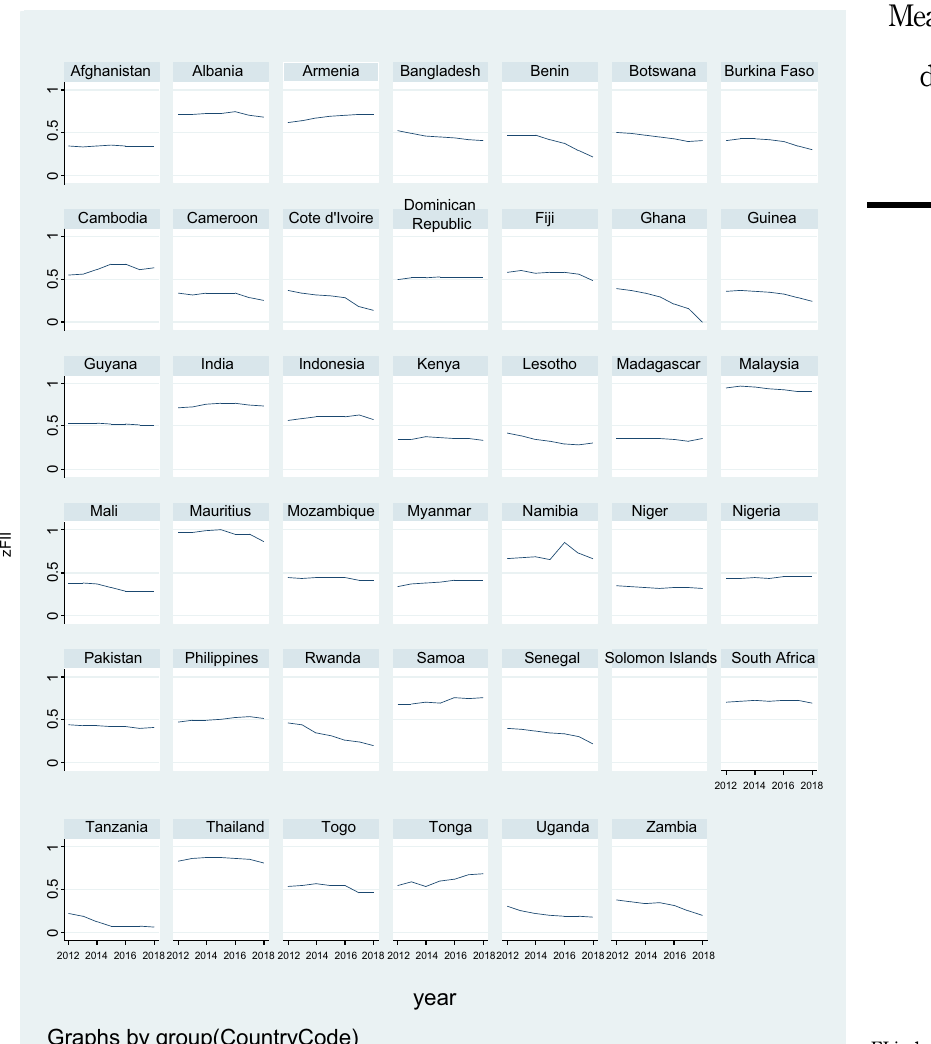
Figure 2. FI index in developing